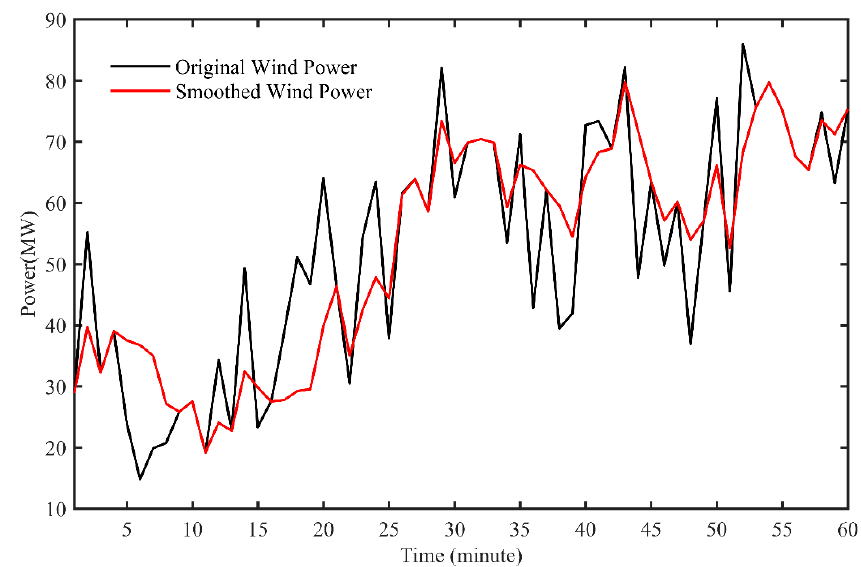
Figure 7. Plot of minute-to-minute BESS requirement and optimal BESS power.